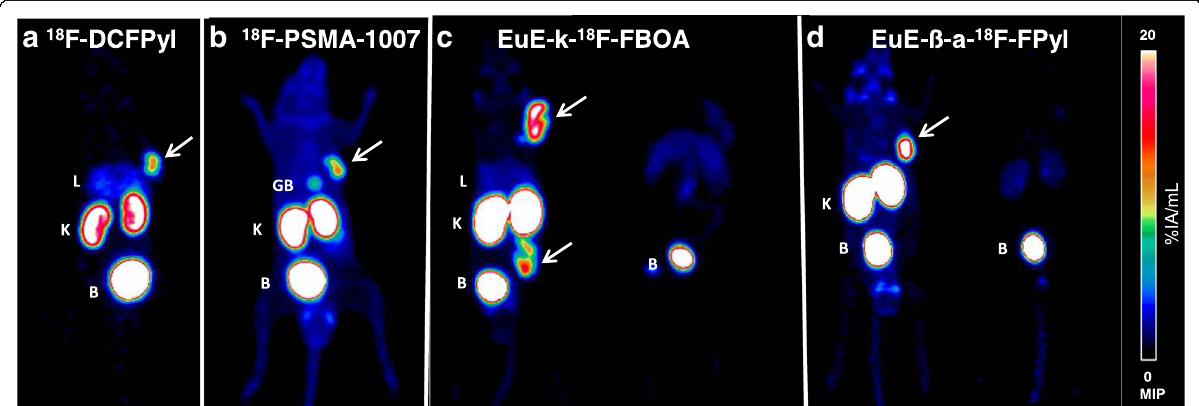
Fig. 3 Maximum intensity projections (MIP) of micro PET scans. Summation image (60 – 90 min p.i.; 0% to 20% IA/mL) of LNCaP-tumor-bearing SCID mice after injection of approximately 0.9 – 1 MBq of a 18 F-DCFPyl; b 18 F-PSMA-1007; c left: EuE-k- 18 F-FBOA, right: EuE-k- 18 F-FBOA + blocking with 8 mg/kg PMPA; d left: EuE-k- β -a- 18 F-FPyl, EuE-k- β -a- 18 F-FPyl + blocking with 8 mg/kg (PMPA). LNCaP tumors are indicated with arrows (please note that the animal shown in panel c bears LNCaP tumors at the right shoulder and on the flank of the hind leg). Organs are marked as B = bladder, GB = gallbladder, K = kidney, L =